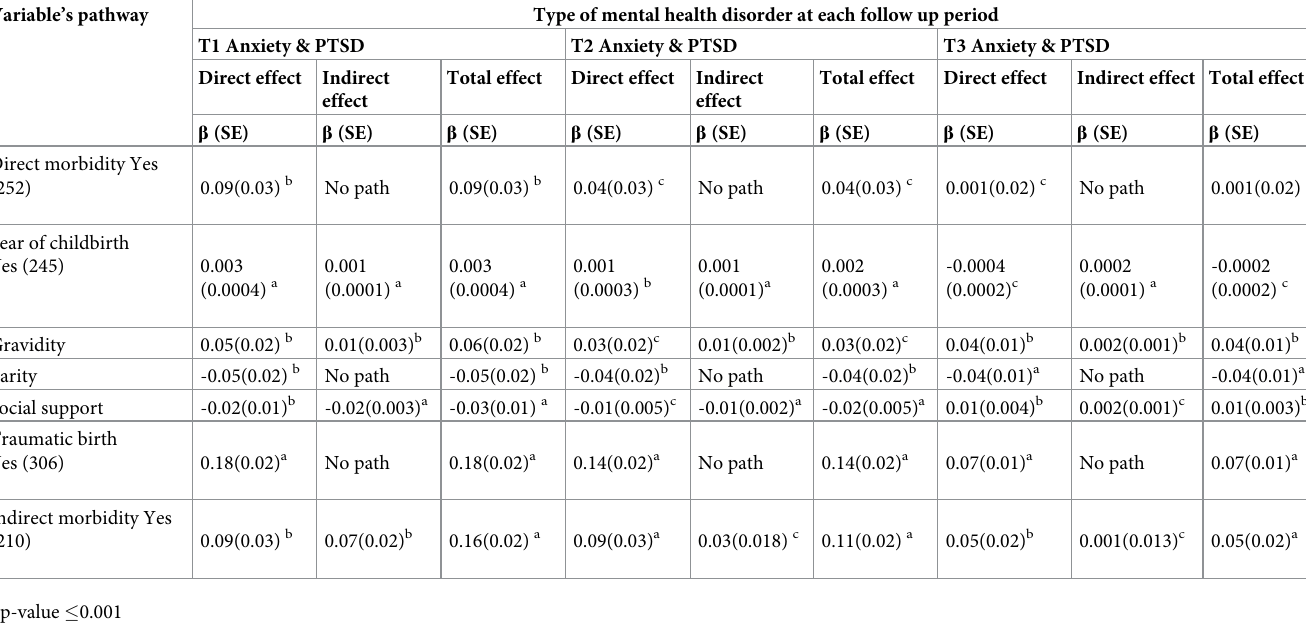
Table 6. Direct, Indirect and total effects of variables associated with comorbidity of anxiety with PTSD, among postpartum women in Northwest Ethiopia, 2021. Variable’s